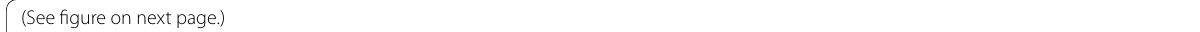
figure on next Fig. 1 A Coronal fat-suppressed PD-weighted MRI image shows capsular edema at glenoid and humeral portions of capsule (arrows). B Sagittal T2-weighted MRI image shows anterior extracapsular edema (arrow). C Sagittal T2-weighted MRI image shows complete obliteration of subcoracoid fat triangle (encircled area). D Axial fat-suppressed PD MRI image shows effusion at long head biceps tendon sheath more than 2 mm (arrow). E Axial fat-suppressed PD-weighted MRI image shows extracapsular edema (encircled area). F Coronal T2-weighted MRI image shows maximum capsular thickening at glenoid portion of axillary recess, the humeral portion was obliterated and fibrotic. G , H Coronal fat-suppressed PD-weighted MRI image shows measurement of maximal height and width of axillary